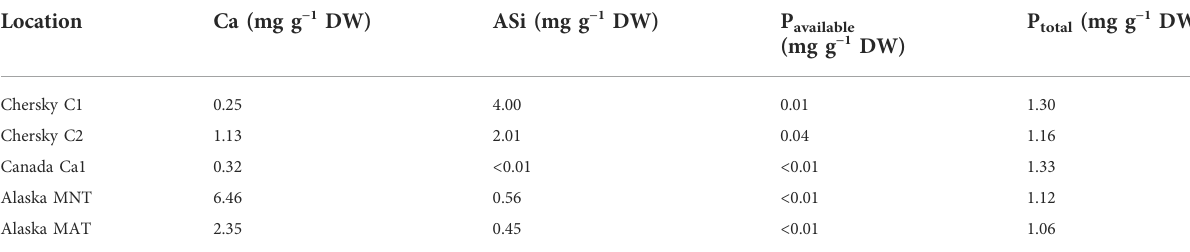
TABLE 2 Element concentrations of the fi ve incubated soils. Ca and available P (P available ) were extracted with the Mehlich III method, ASi with the alkaline extraction, and total P (P total ) with the aqua regia extraction. Location